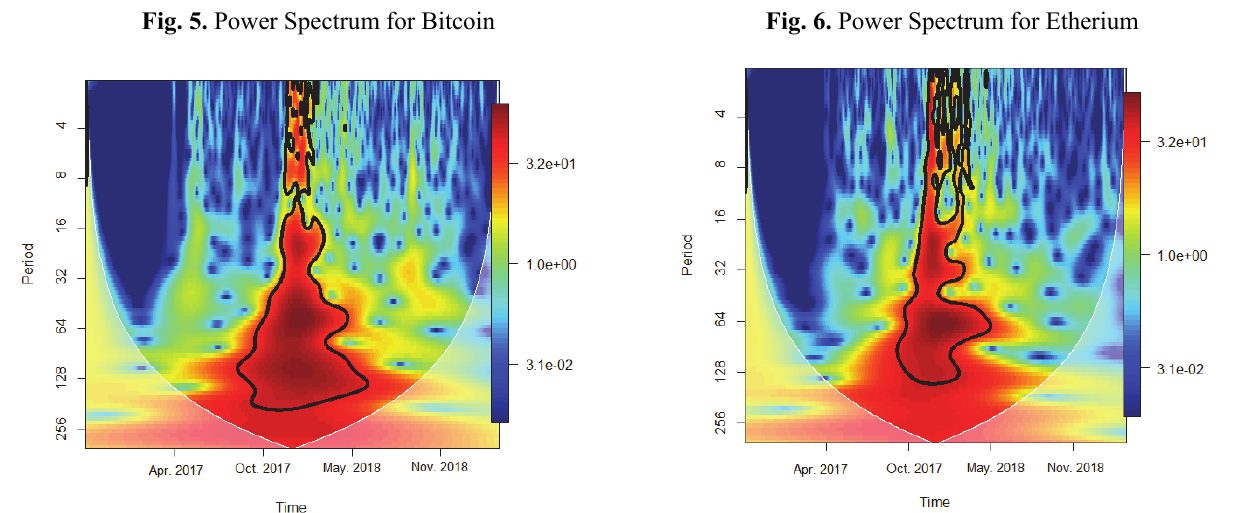
Fig. 7. Power Spectrum for Ripple Fig. 8. Power Spectrum for